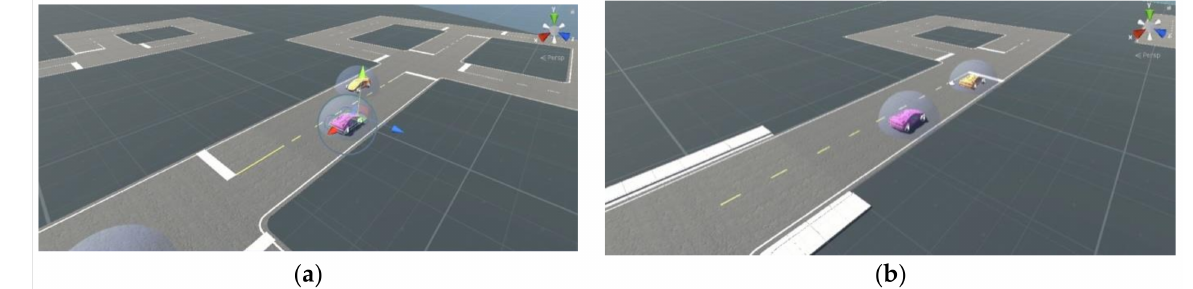
Figure 4. ( a ) Vehicle crossing scenario, ( b ) vehicle braking